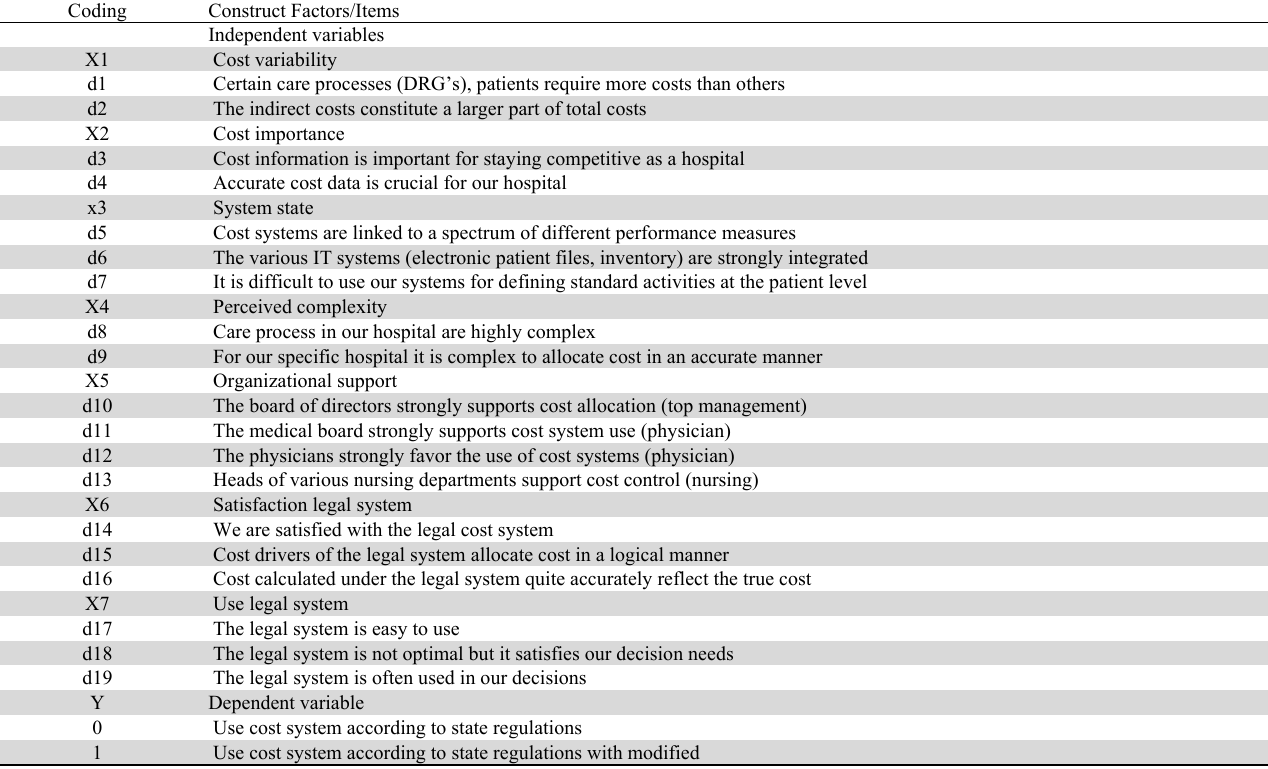
The constructs of the adapted research model with relevant studies